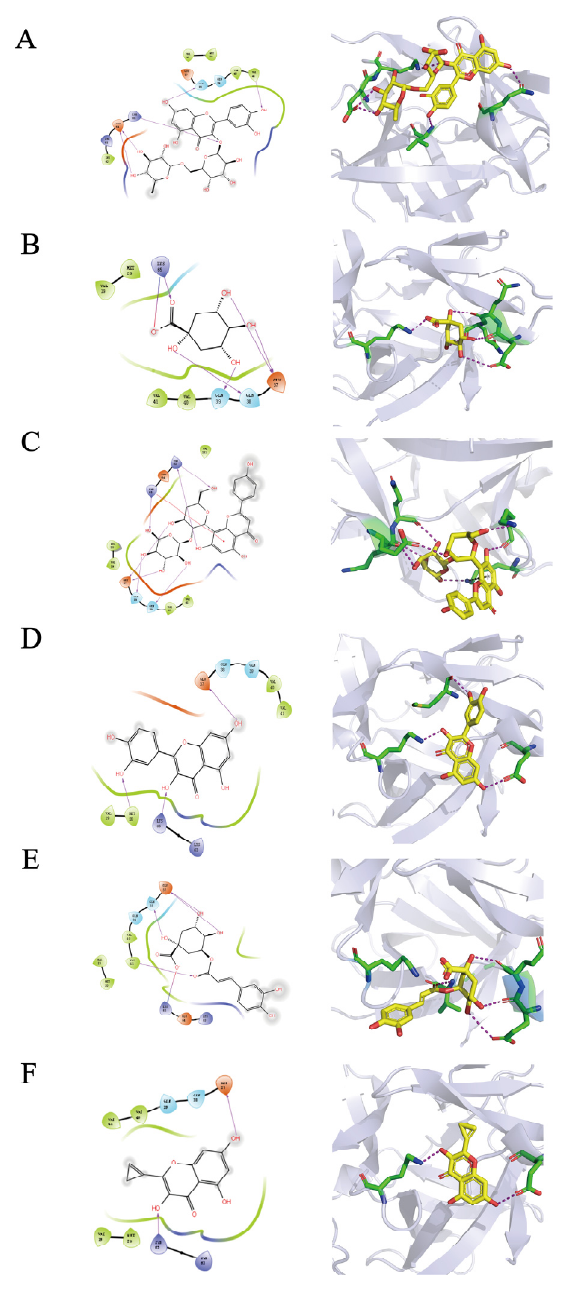
Figure 8. 2D and 3D interaction diagrams of compounds in the active site of IL-1 β . ( A ) rutin; ( B ) quinic acid; ( C ) vitexin; ( D ) quercetin; ( E ) chlorogenic acid; ( F ) Kaempferol.